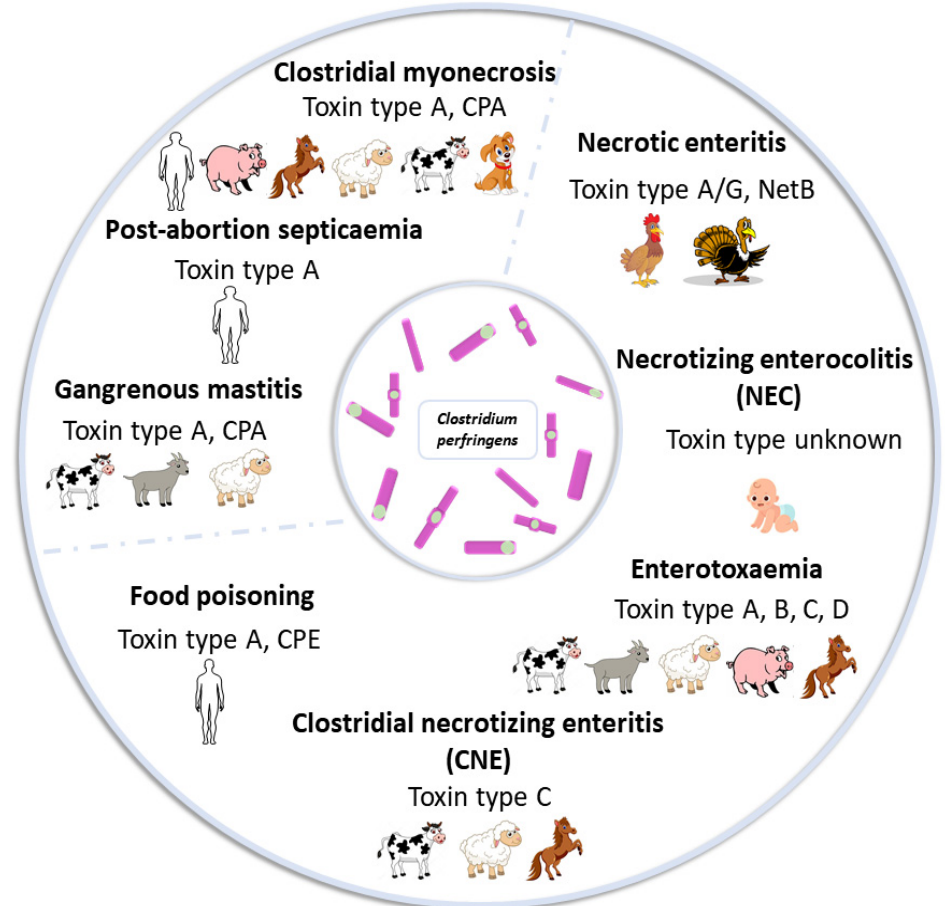
Figure 1. Overview of C. perfringens -induced diseases.